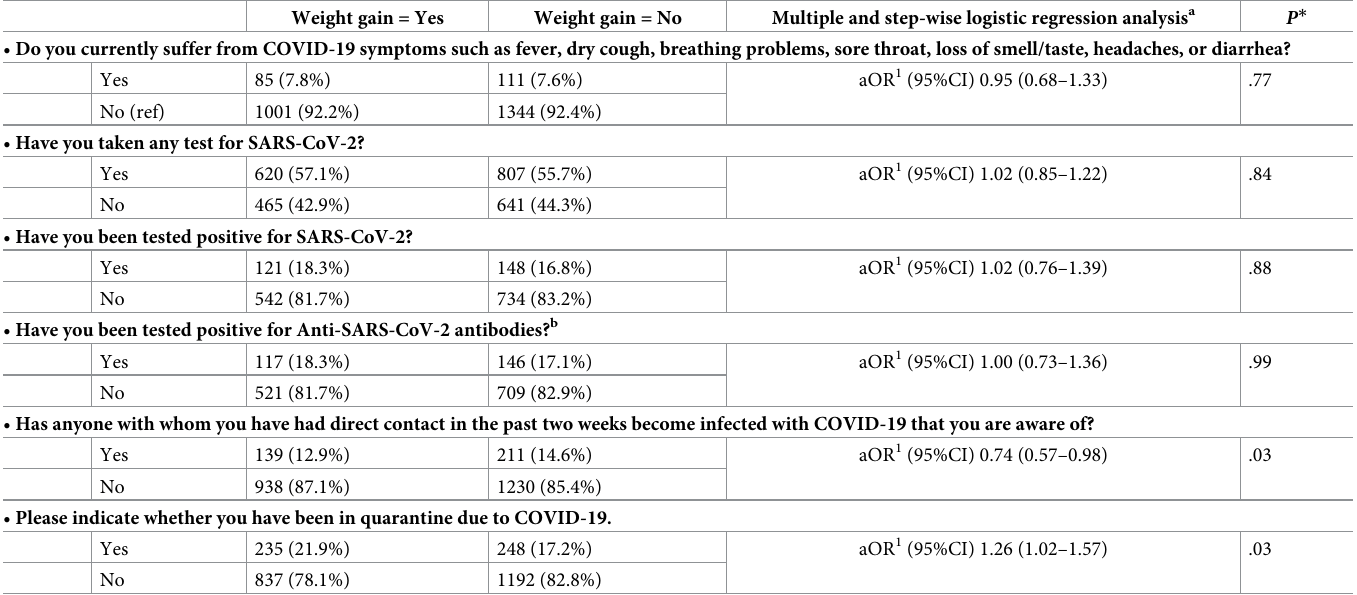
Table 3. Associations between COVID-19 related personal experience and increased